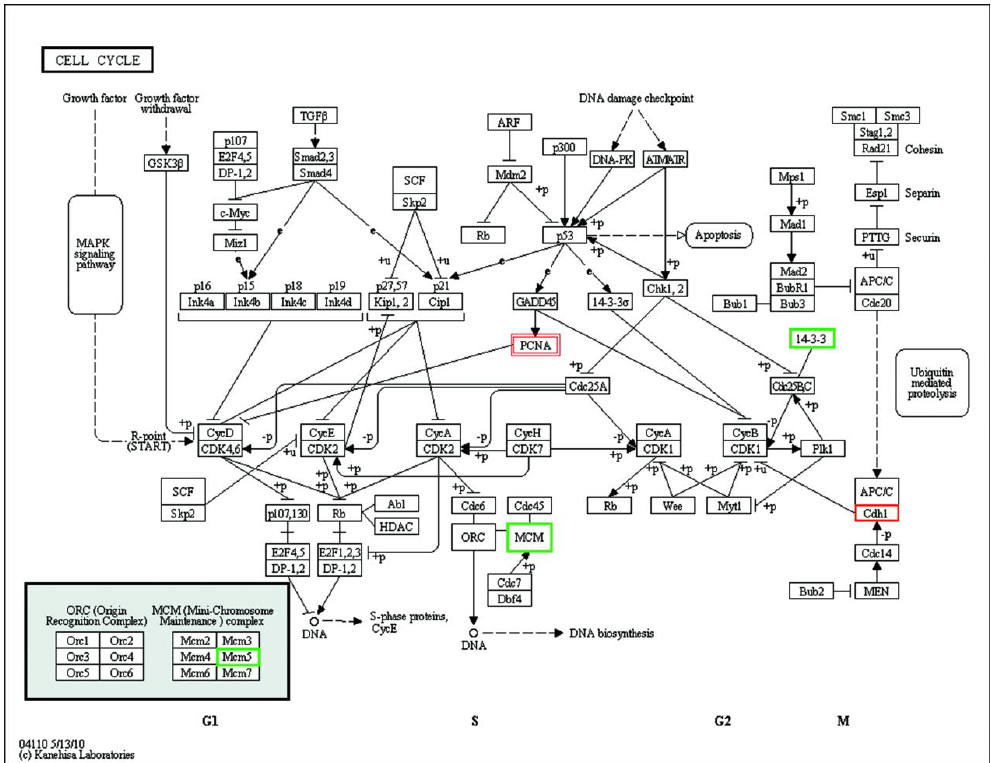
Figure 4. KEGG pathway analysis of the cell cycle in GNP-treated cells. PCNA was up-regulated in CTAB-GNP treated cells. Cdh1 was up-regulated, whereas 14-3-3 protein and MCM5 were down-regulated in BSA-GNP-treated cells. Single line frames refer to BSA-GNPs, and double line frames refer to CTAB-GNPs. Red frames indicate up-regulated proteins, and green frames indicate down-regulated proteins.